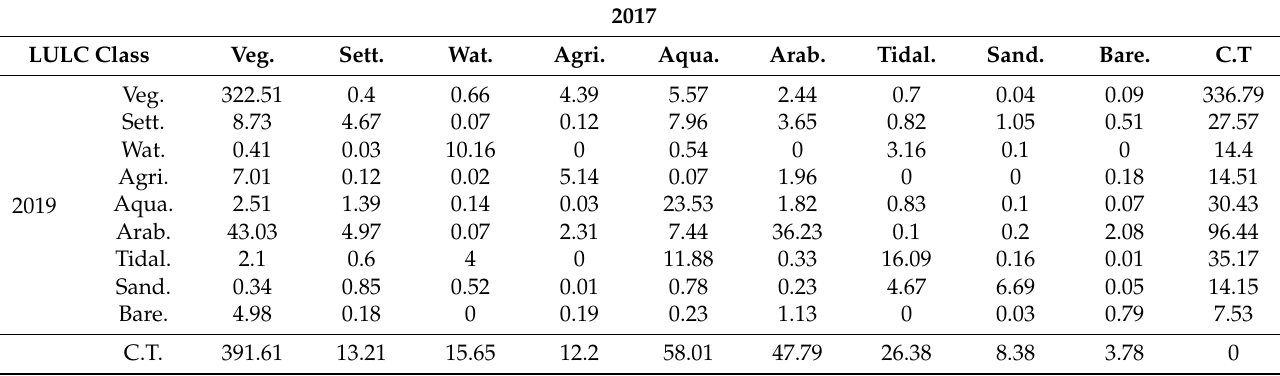
Table A5. Spatiotemporal transition of LULC, Ukhiya-Teknaf, 2017–2019 (in km 2 ), here, Veg. = vegetative, Sett. = Settlement, Wat. = Water-body, Agri. = Agricultural land, Aqua. = Aquaculture land, Arab. = Arable land, Tidal. = Tidal Mudflat, Sand. = Sandy area, Bare. = Bare land.